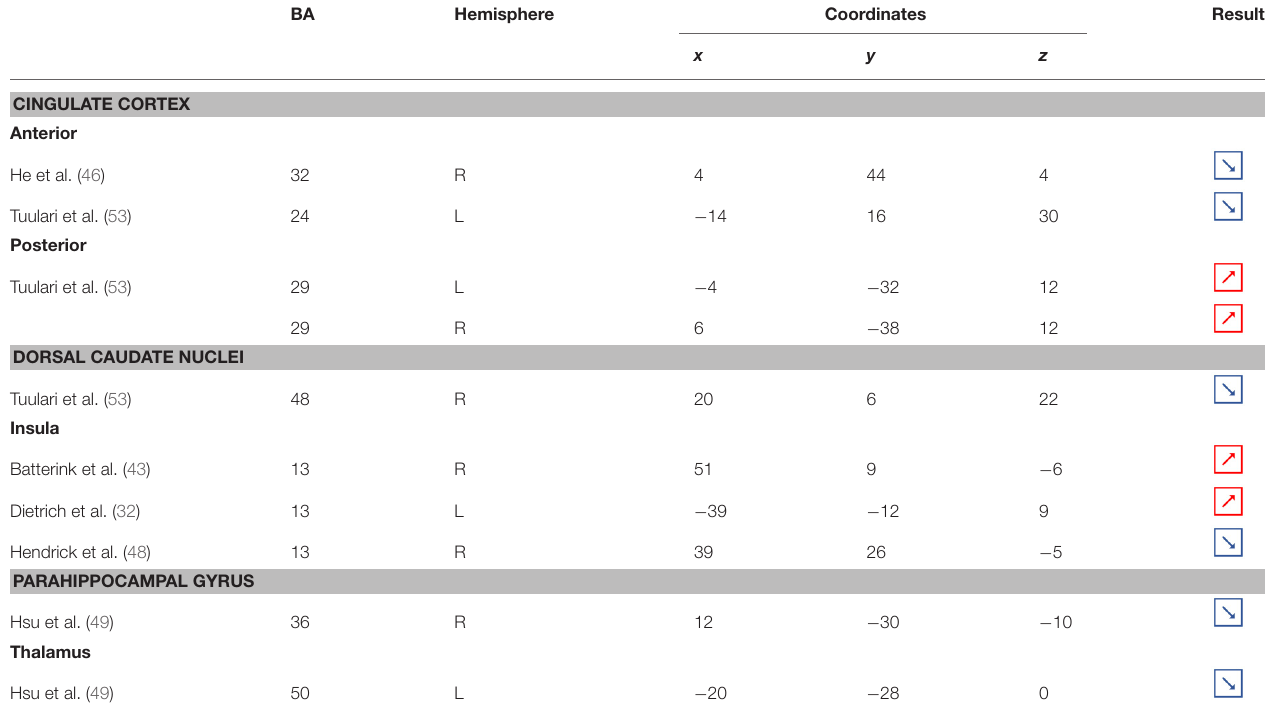
Blue arrows indicate hypoactivity in obese in comparison with lean subjects. Red arrows indicate hyperactivity in obese in comparison with lean subjects. BA, Brodmann area.